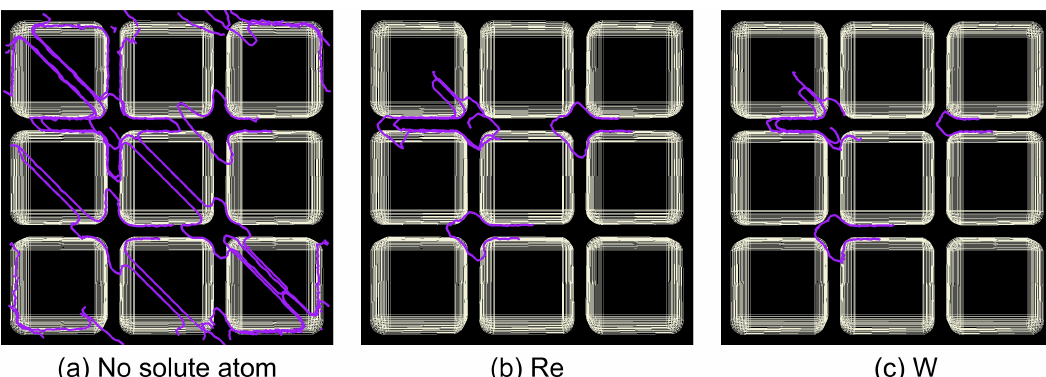
Figure 5. Dislocation patterns in the [0¯11](111) slip system in γ matrix channels after 30 ns under 500 MPa tensile load along [001] direction at 850 ◦ C for different solute atoms. Dislocations are viewed in the projection on (100) crystallographic planes, corresponding to Figure 1: ( a ) no solute atom; and ( b ) 7 × 10 − 3 at.% Re; ( c ) 7 × 10 − 3 at.%